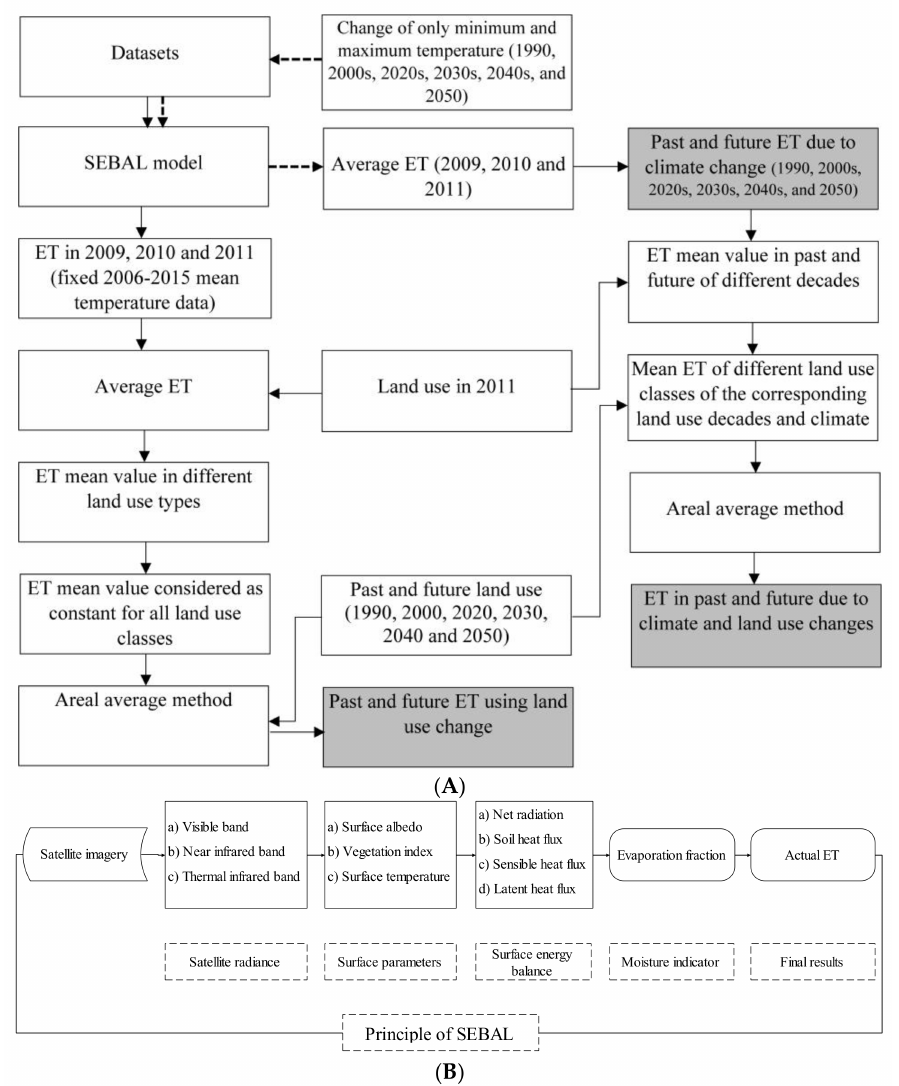
Figure 2. ( A ) Process of future land use and climate change on future actual ET; ( B ) Principle of the SEBAL